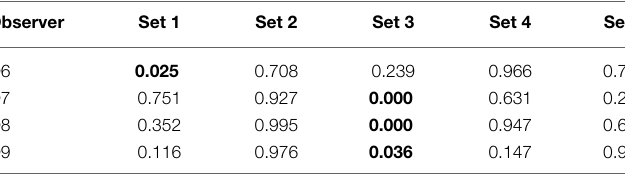
Bold values represent P-values smaller than 5% rejecting a null